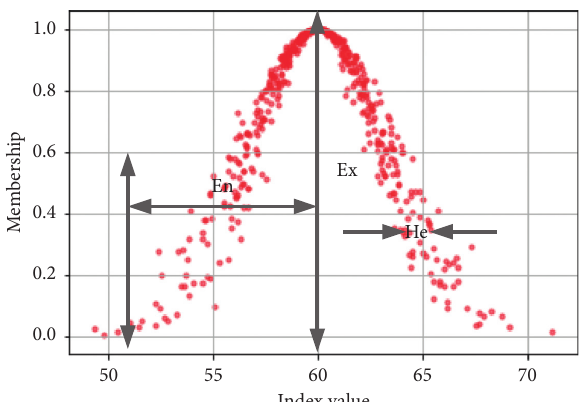
Figure 1: Illustration of a standard cloud model by its eigenvalues ( E